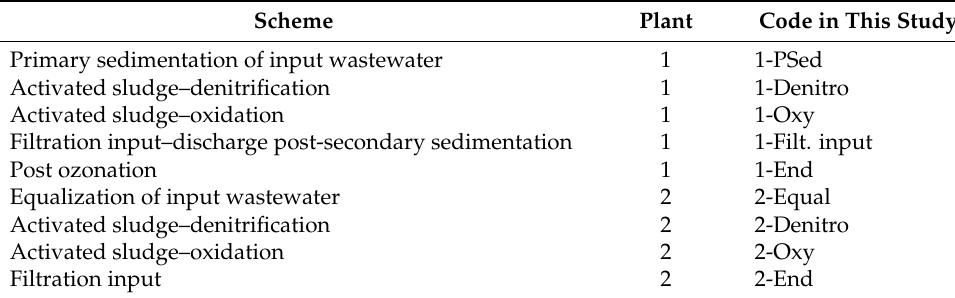
Table 1. Treatment stages examined in this study.